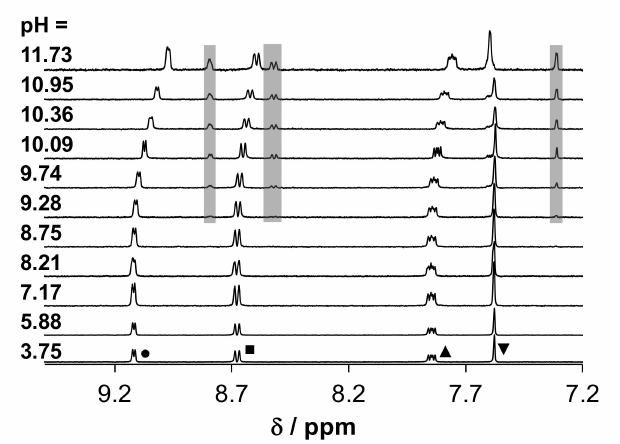
Figure 7. 1 H NMR spectra of the RhCp*–HQCl-D-Pro (1:1) system at various pH values in the high-field region. For the peak assignation, see the legend of Figure 4. Grey boxes show the peaks of the minor species. { c RhCp* = c ligand = 500 µ M; 10% ( v / v ) D 2 O); I = 0.2 M KNO 3 ; T = 25.0 ◦